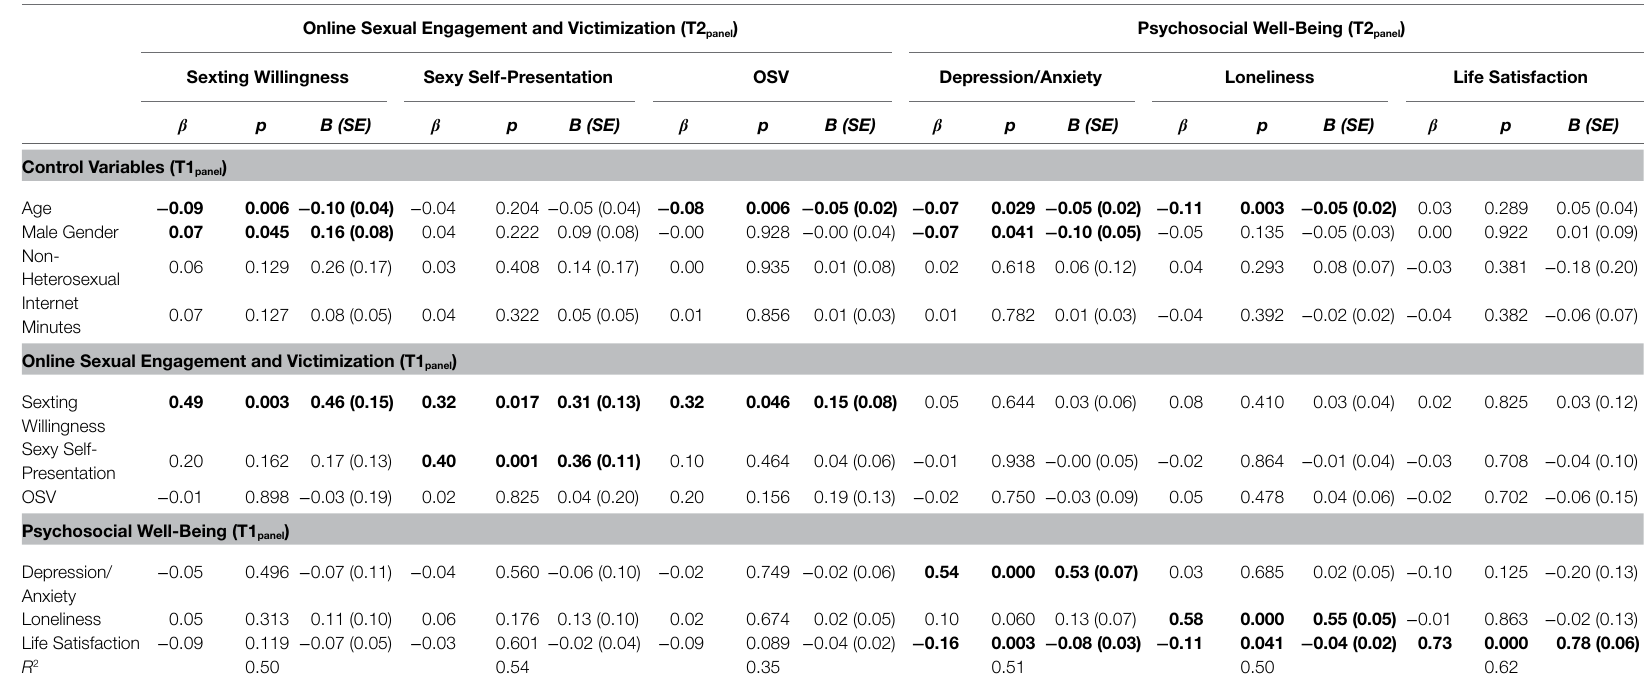
TABLE 2 | Longitudinal relationships between online sexual engagement, victimization, and psychosocial well-being. Online Sexual Engagement and Victimization (T2 panel ) Psychosocial Well-Being (T2 panel ) Sexting Willingness Sexy Self-Presentation OSV Depression/Anxiety Loneliness Life